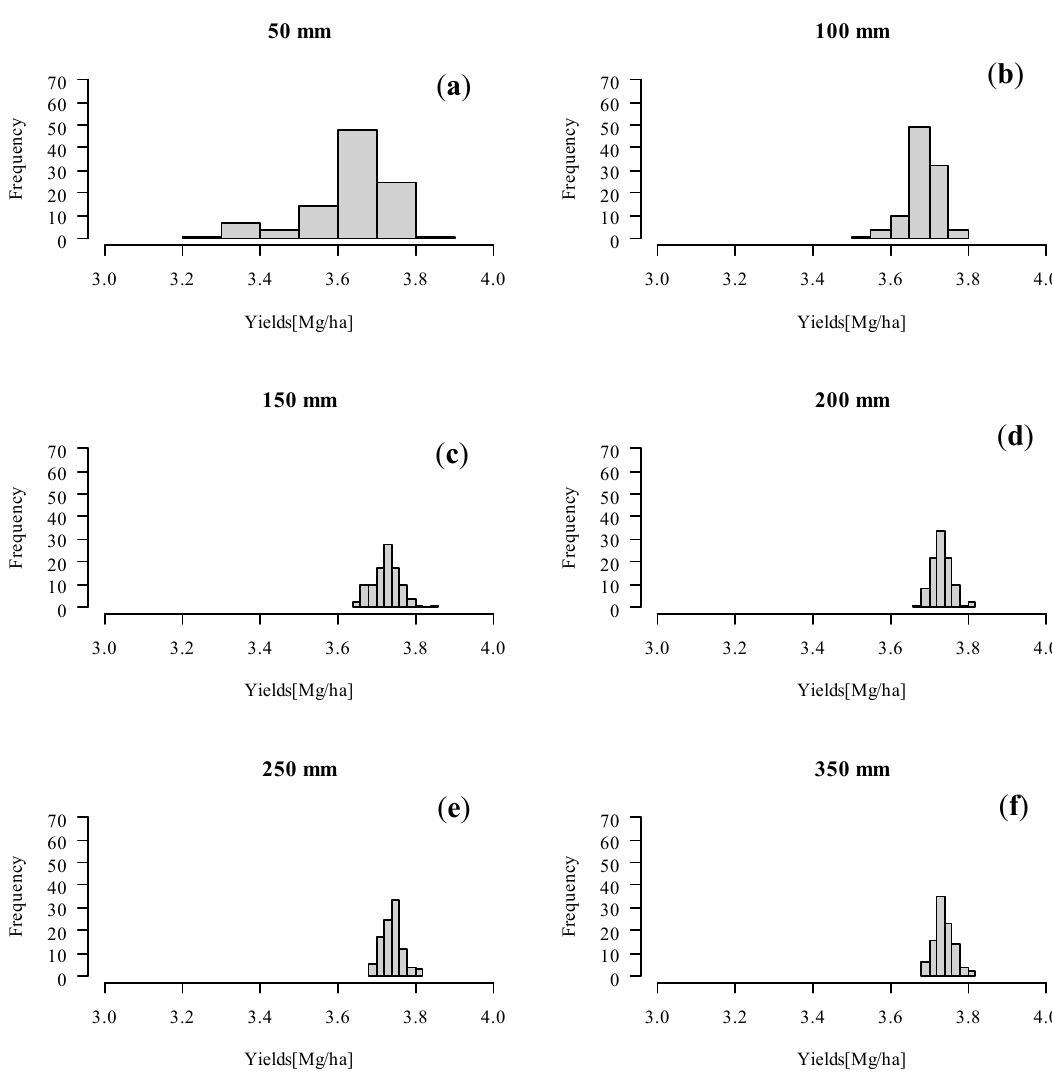
Figure 7. Histogram of distributions of expected yield using water for supplemental irrigation of maize in the wet season in Dapaong: ( a ) 50 mm; ( b ) 100 mm; and ( c ) 150 mm (WS-CDI); and ( d ) 200 mm; ( e ) 250 mm; and ( f ) 350 mm (WS-FI).